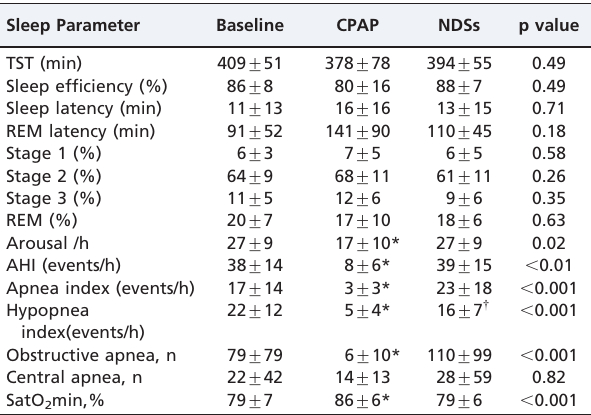
Table 2 - Sleep parameters of the participants at baseline, on nasal dilator strips and on